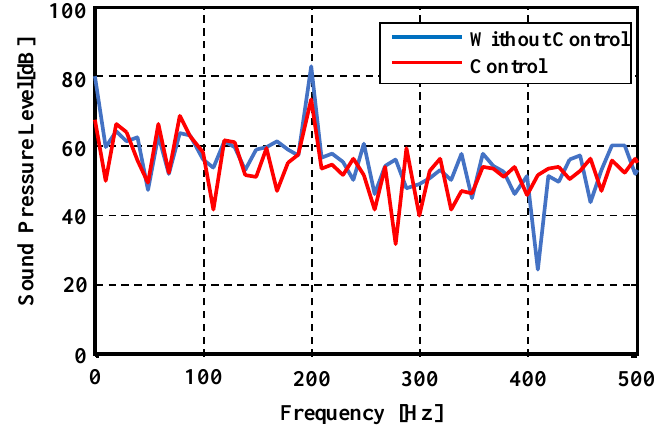
Figure 5. All ‐ pass filter 200 Hz.